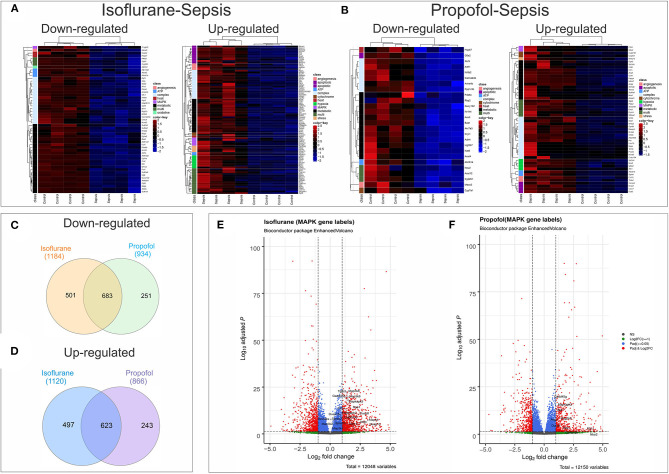
Anesthesia-Sepsis-associated alterations in liver gene expression profiles. Heatmap of genes* that were differentially expressed (adjusted P-value or Benjamini-Hochberg (BH) adjustment < 0.05; log2 fold change> 2 for up-regulated and log2 fold change < -2 for down-regulated genes) during sepsis under (A) Isoflurane background (B) Propofol background (C) Venn diagram showing number of common and unique genes downregulated (adjusted P < 0.05) in sepsis with Isoflurane and Propofol backgrounds. No cut off for log2 fold change was used to avoid any bias in representing the gene counts that are unique for only one group. (D) Venn diagram showing number of common and unique genes up-regulated (adjusted P < 0.05) in sepsis with Isoflurane and Propofol backgrounds. No cut off for log2 fold change was used. (E) Volcano plot for differentially expressed genes in sepsis with a Propofol background. Genes related to MAPK that were significant (adjusted P < 0.05 and log2 fold change> 1) are labeled in the plot. (F) Volcano plot for differentially expressed genes in sepsis with an Isoflurane background. Genes related to MAPK that were significant (adjusted P < 0.05 and log2 fold change> 1) are labeled in the plot. *Genes displayed in the heatmap are differentially expressed genes (adjusted P < 0.05) that had gene description lines like-angiogenesis, cytochrome, oxidative, stress, hsp, electron, heat, atp, metabolic, apoptotic/apoptosis, mitochondria, hypoxia, complex, mapk, kappa, and nfk pathways. For genes that matched more than one of these terms were grouped under “multi”.